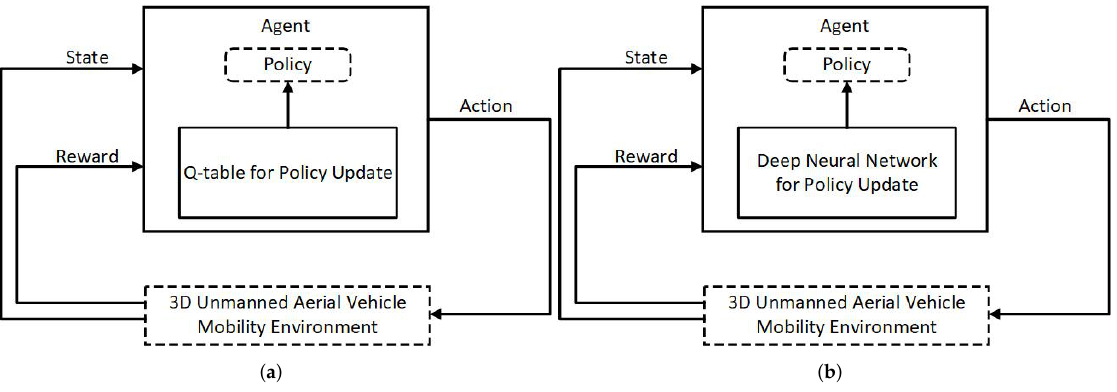
Figure 1. Illustrative comparison between Reinforcement Learning (RL) and Deep Reinforcement Learning (DRL). ( a ) RL with Q-table for policy update. ( b ) DRL with neural network for policy